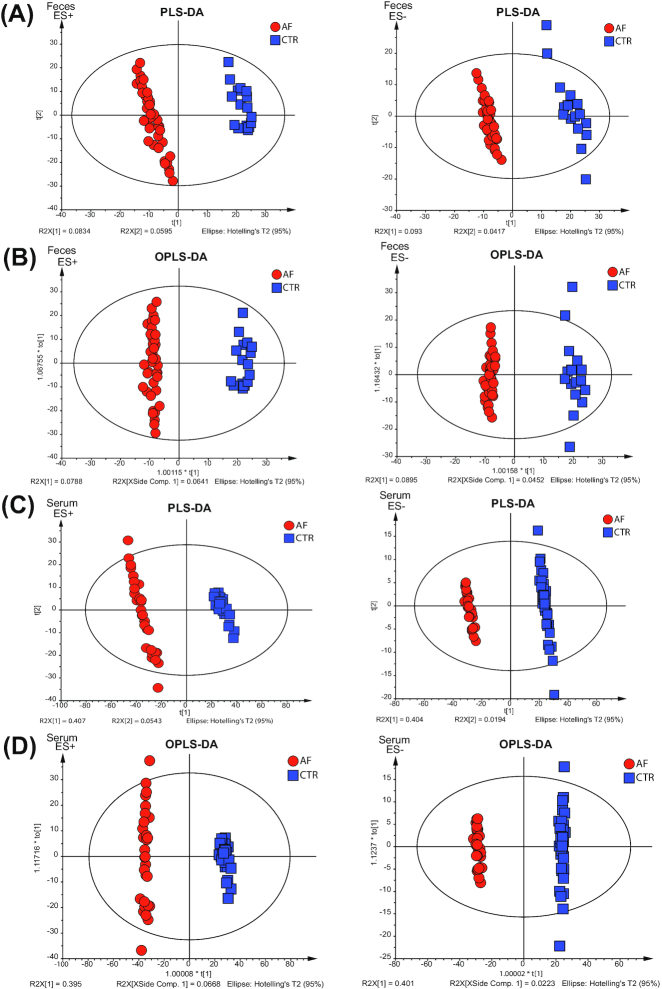
Distinguished metabolic patterns between AF and control (CTR). A. Partial least-squares discriminant analysis (PLS-DA) score plots based on the metabolic profiles in feces samples from the control and AF groups in ES+ and ES−. A clear separation between patients with AF and healthy controls was obtained under both ES+ and ES− modes. B. Score scatter plots of orthogonal PLS-DA (OPLS-SA) comparing the feces metabolic differences identify the separation between AF and control in ES+ and ES−. C, PLS-DA score plots based on the metabolic profiles in serum samples from control and AF group in ES+ and ES−, which successfully classify the 2 groups. D. Score scatter plots of OPLS-DA comparing the serum metabolic differences identify the separation between AF and control in ES+ and ES−.